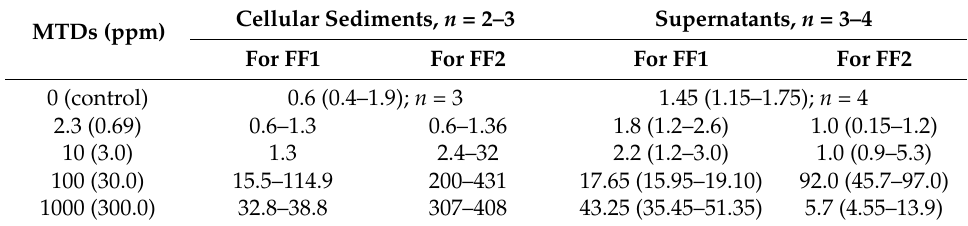
Table 4. The distribution of MNPs in the HBMLs cellular sediment and intercellular fluid (supernatants) according to energy dispersive X-ray fluorescence analysis, Me (Q1–Q3). MTDs (ppm)